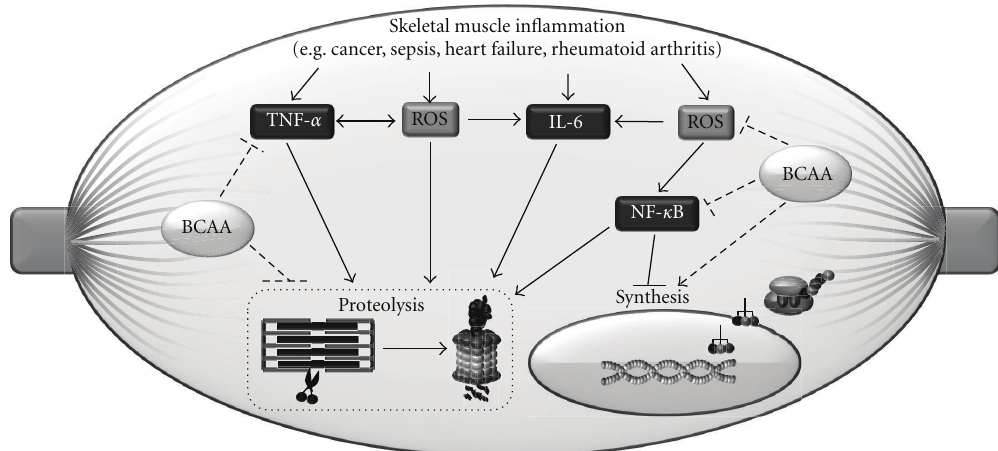
Figure 1: Signaling pathways linking skeletal muscle inflammation and remodeling Possible role of BCAA action. Skeletal muscle inflammation can increase the expression and activity of factors such as TNF- α B, ROS, IL-6, and NF - κ B which in turn could contribute to protein degradation and attenuate protein synthesis. On the other hand, BCAA supplementation could counteract such e ff ects by suppressing skeletal muscle proteolysis and stimulation protein synthesis. BCAA: branched-chain amino acids; IL-6: interleukin 6: NF- κ B, nuclear factor kappa B: ROS: reactive oxygen species; TNF- α : tumor necrosis